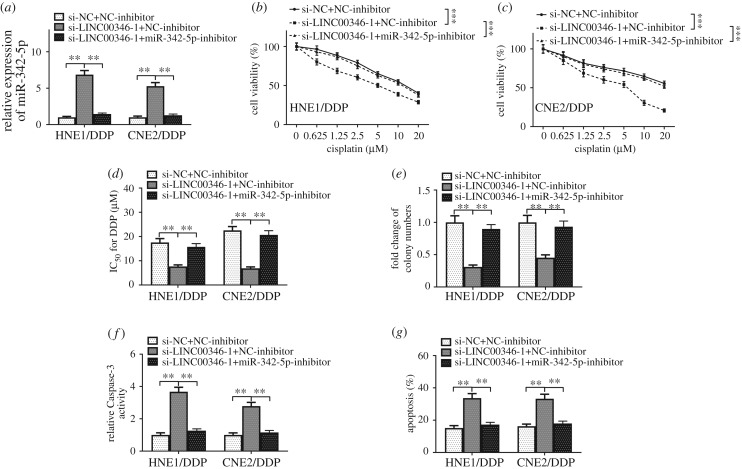
miR-342-5p knockdown rescues the effect of LINC00346 inhibition on NPC cell cisplatin resistance. (a) miR-342-5p expression in HNE1/DDP and CNE2/DDP cells co-transfected with si-LINC00346 and miR-342-5p-inhibitor. (b,c) miR-342-5p inhibition rescues the decreased cell viability due to LINC00346 inhibition on HNE1/DDP and CNE2/DDP cells. (d) HNE1/DDP and CNE2/DDP cells co-transfected with si-LINC00346 and miR-342-5p-inhibitor were treated with different concentrations of cisplatin for 48 h to determine the IC50. (e) MiR-342-5p inhibition rescues the decreased ability of colony formation due to inhibition of LINC00346 expression in HNE1/DDP and CNE2/DDP cells treated 1 µM cisplatin. (f,g) Histone/DNA ELISA and Caspase-3 activity assay indicated that miR-342-5p inhibition rescues the increased cell apoptosis due to inhibition of LINC00346 in HNE1/DDP and CNE2/DDP cells with the cisplatin treatment (1 µM). The data show mean ± s.d. **p < 0.01; ***p < 0.001.